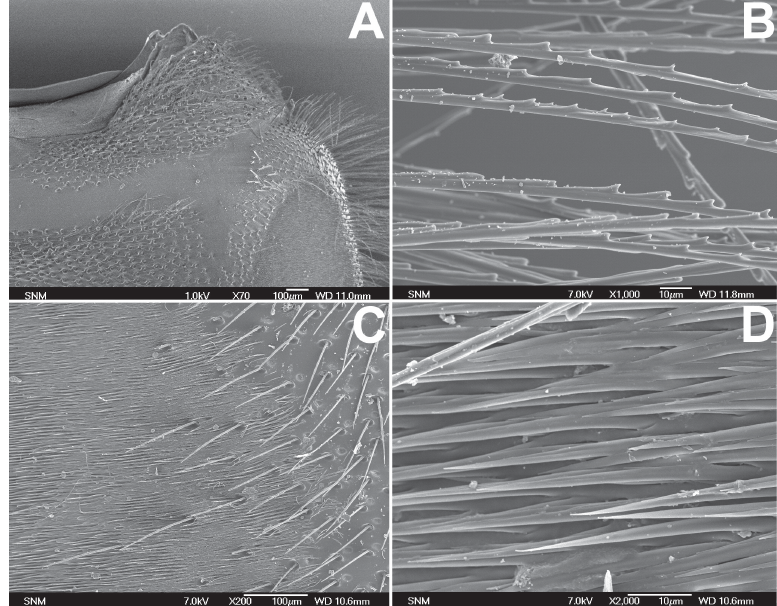
Fig. 9. Megatrigon argenteus (Walker, 1852) comb. nov., tergites, ♂ (SeM). A . Tergite 2, anterior corner. B . Tergite 4, setae. C . Tergite 3, silver spot. D . Tergite 3, enlarged microtrichia of silver